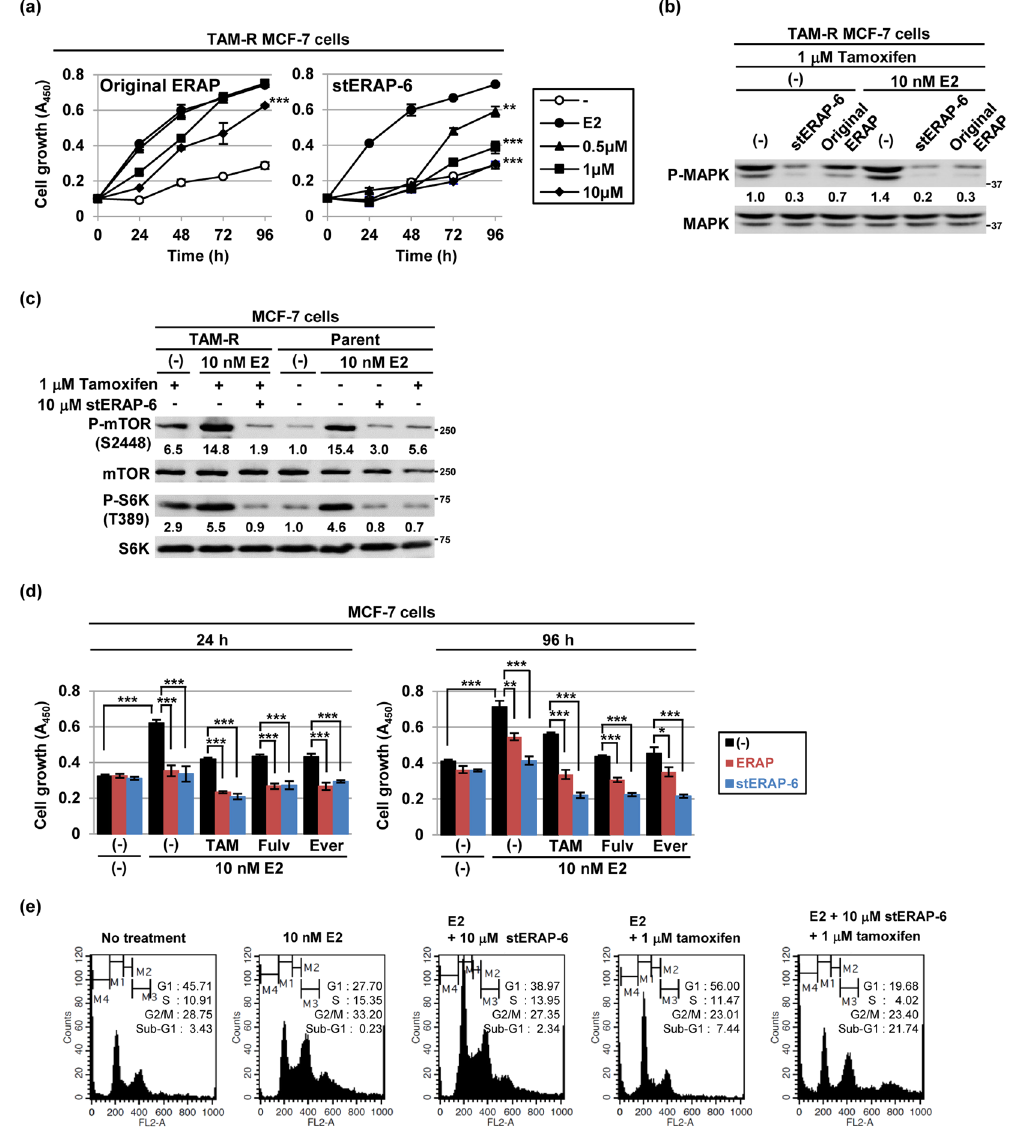
Figure 4. Stapled ERAP inhibits the E2-dependent growth of tamoxifen-resistant MCF-7 cells. ( a ) MTT assays evaluating the inhibitory effect of unstapled, original ERAP (left) and stERAP-6 (right) on the growth of tamoxifen-resistant (TAM-R) MCF-7 cells. TAM-R MCF-7 cells were treated with unstapled original ERAP or stERAP-6 in the presence of 10 nM E2 and 1 μ M tamoxifen (TAM) at 0 h. The data represent the mean ± s.d. of three independent experiments. ( b , c ) Immunoblot analysis evaluating the phosphorylation levels of MAPK ( b ), mTOR, and S6K ( c ) in TAM-R MCF-7 cells. ( d ) The combined inhibitory actions of stERAP-6 and tamoxifen (TAM), fuluvestrant (Fulv) or everolimus (Ever) assessed via MTT assays. MCF-7 cells were treated for 24 h and 96 h with 10 nM E2 ± 10 μ M stERAP-6, 10 μ M unstapled original ERAP, 1 μ M TAM, and a combination of stERAP-6 or unstapled original ERAP and 1 μ M TAM, 2 μ M Fulv or 0.5 μ M Ever. The data represent the mean ± s.d. of three independent experiments. ** P < 0.01 and *** P < 0.001 via two-sided Student’s t -tests. ( e ) Flow cytometric analyses evaluating the effect of stERAP-6 treatment on the cell cycle of MCF-7